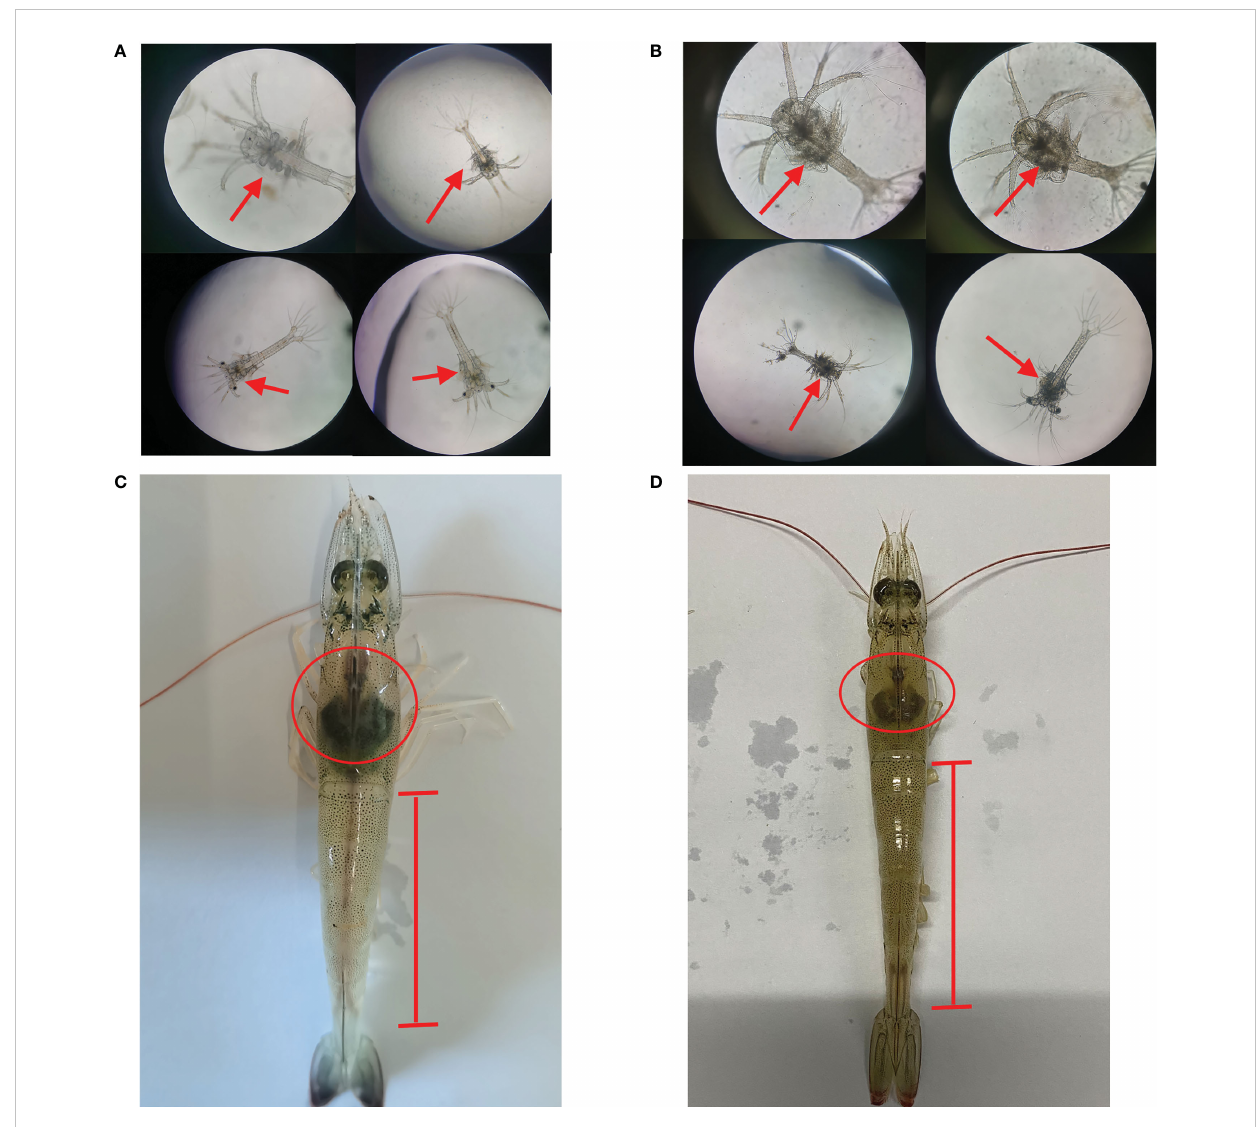
FIGURE 1 External signs of Zoea larvae and adults shrimp infected with Vibrio parahaemolyticus . (A) Normal Zoea larvae. (B) Larvae infected with Vibrio parahaemolyticus . (C) Normal adult shrimp. (D) Adult shrimp infected with Vibrio parahaemolyticus